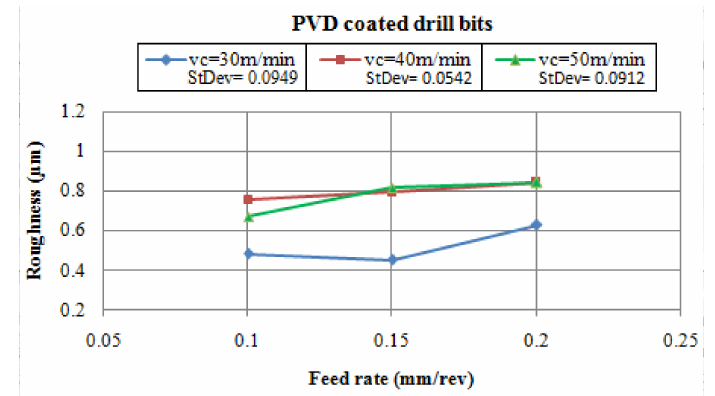
Figure 9. Surface roughness with feed rates at different cutting speeds when using uncoated drill bits.